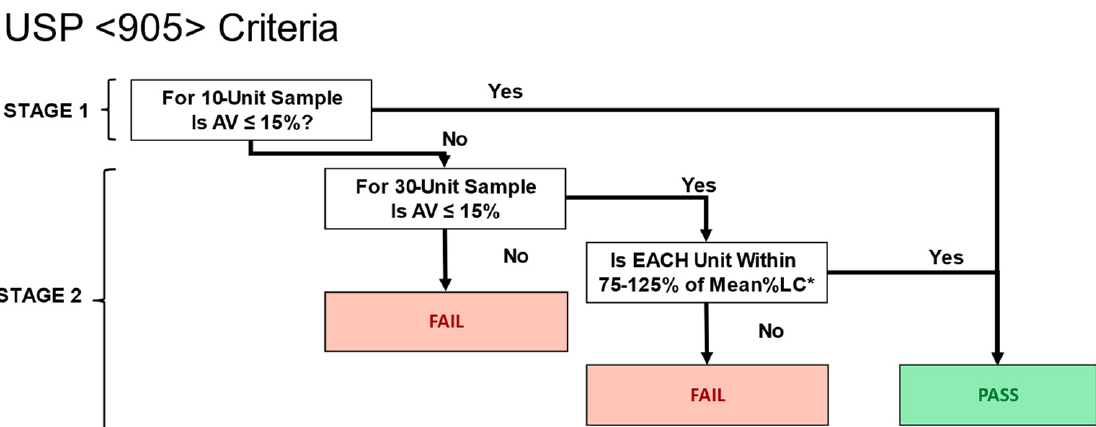
Figure 2. Simplified representation of USP <905> model decision matrix for CU assessment. In the Stage 1 assessment, the contents of 10 individual sachets are assayed to calculate an acceptance value (AV). If the AV is less than 15%, the batch passes CU testing. However, if the AV is greater than or equal to 15%, Stage 2 testing is required. In Stage 2 testing, the contents of additional 20 sachets are assayed, and data are aggregated with the initial ten sachets from stage 1. As in stage 1, an AV is calculated and compared to the 15% threshold. If AV is greater than 15% in Stage 2, the batch fails CU testing. If it passes, an additional criterion is required for the contents of individual sachets. Here, the contents of each sachet must be within plus/minus 25% of the target label claim. Failure to meet this criterion results in batch failure, and success results in batch passage of CU criteria. * Note, this criterion represents the case where the mean %LC is 98.5–101.5% of the target. It varies slightly if the mean %LC is outside this range and may be as low as 73.875–123.125% and as high as 76.125–126.875%.